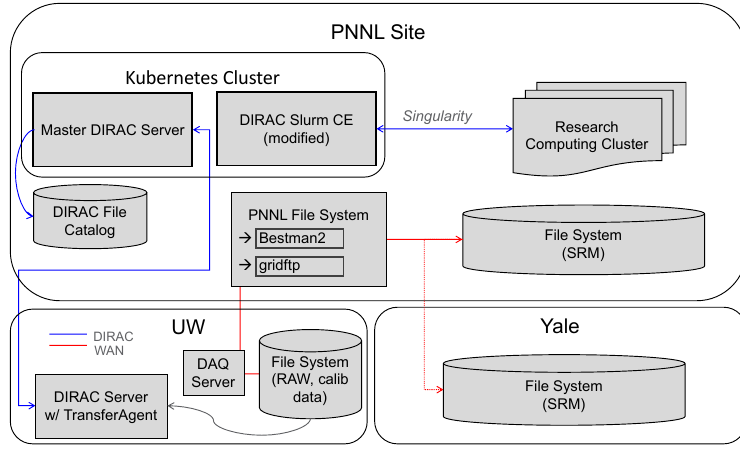
Figure 1. Current Project 8 computing